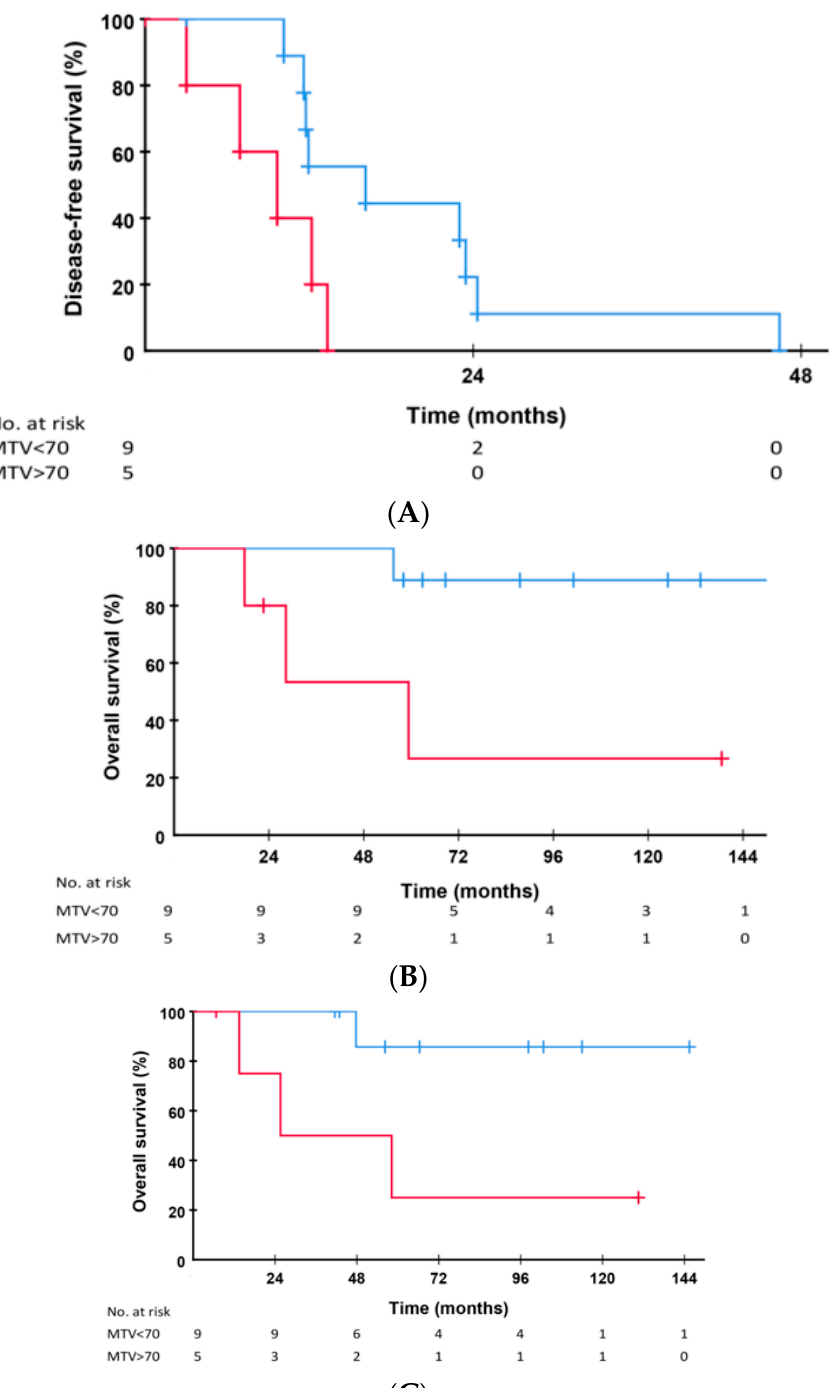
Figure 2. ( A ) Disease-free survival from time of liver transplantation (LT) in the 14 patients who had lung metastases as first site of relapse after LT and received resection of the pulmonary lesion (s) as first treatment. Patients ith low liver PET metabolic volume (MTV) ( n = 9, blue line) versus patients with high MTV values ( n = 5, red line, p = 0.063). ( B ) Overall survival from time of relapse in the 14 patients who had lung metastases as first site of relapse after LT and received resection of the pulmonary lesion (s) as first treatment. Patients with low liver PET metabolic volume (MTV) ( n = 9, blue line) versus patients with high MTV values ( n = 5, red line, p = 0.013). ( C ) Overall survival from time of pulmonary resection in patients with low ( n = 9, blue line) versus high MTV-values ( n = 5, red line, p = 0.023).